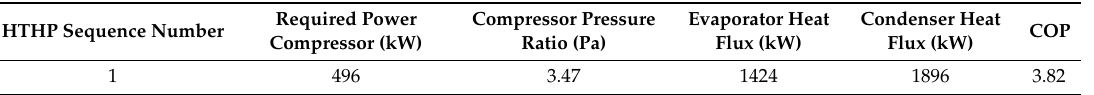
Table 3. Summary of the results of the computer simulation of the high-temperature heat pump from Figure 3.